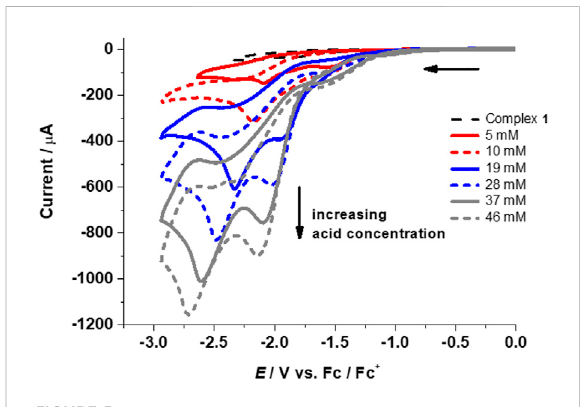
FIGURE 5 CVs for complex 1 (1 mM) in the absence (top curve, dashed black line) and presence of TFA (5 – 46 mM) at 0.1 Vs ‒ 1 .